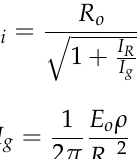
Figure 10. Tower T40 soil profile interpretation.